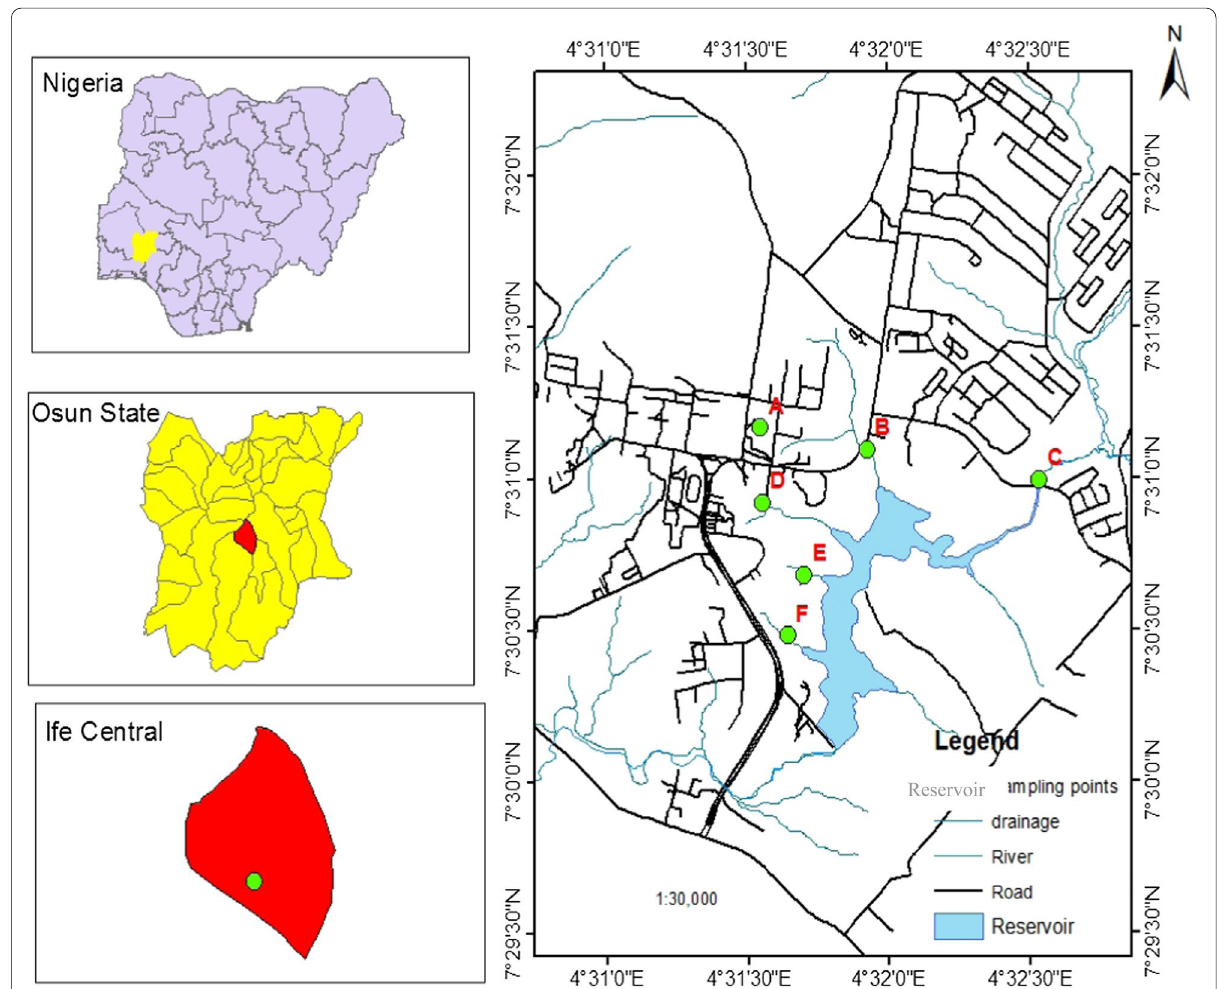
Fig. 1 Map of Opa Reservoir wetlands showing the sampling stations (inset: maps of Nigeria, Osun State, and Ife Central LGA), A—Road 7 Bridge site, B—OAU International School Site, C—Health-Sciences building Site, D—Gender Studies Site, and E—Road 1